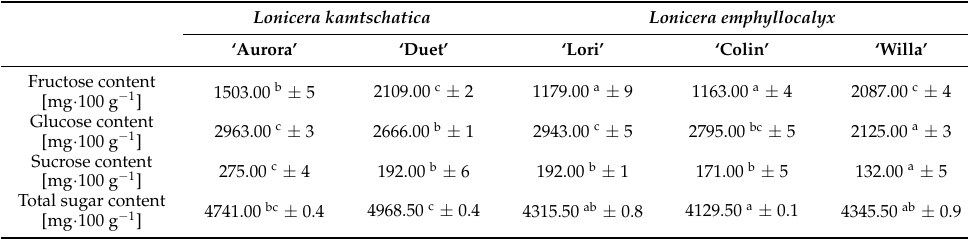
Table 3. Total sugar content of the fruits of L. kamtschatica and L. emphyllocalyx